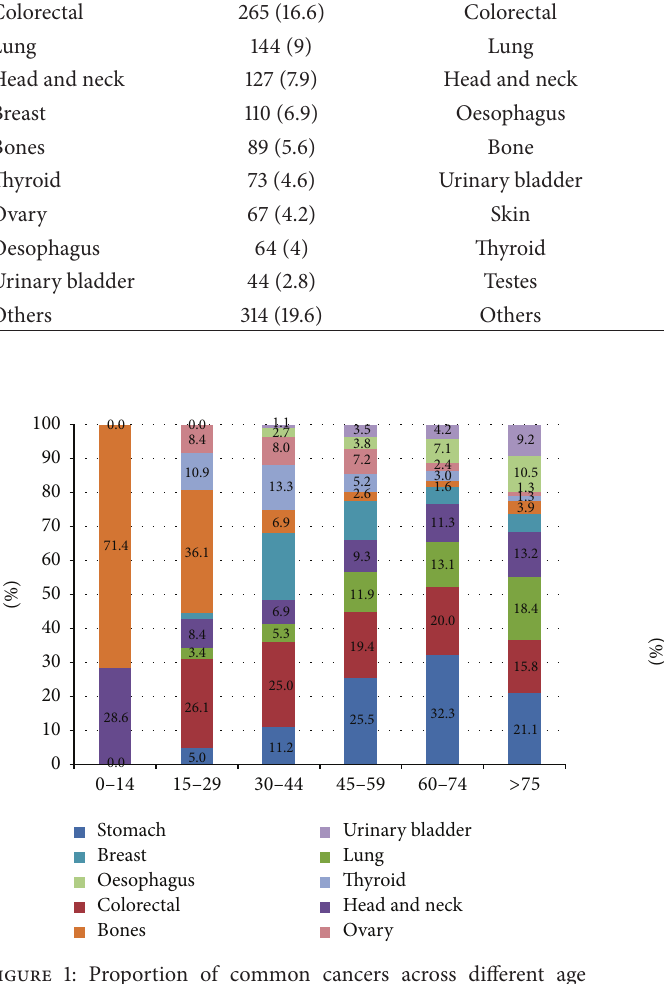
Figure 1: Proportion of common cancers across different age groups.